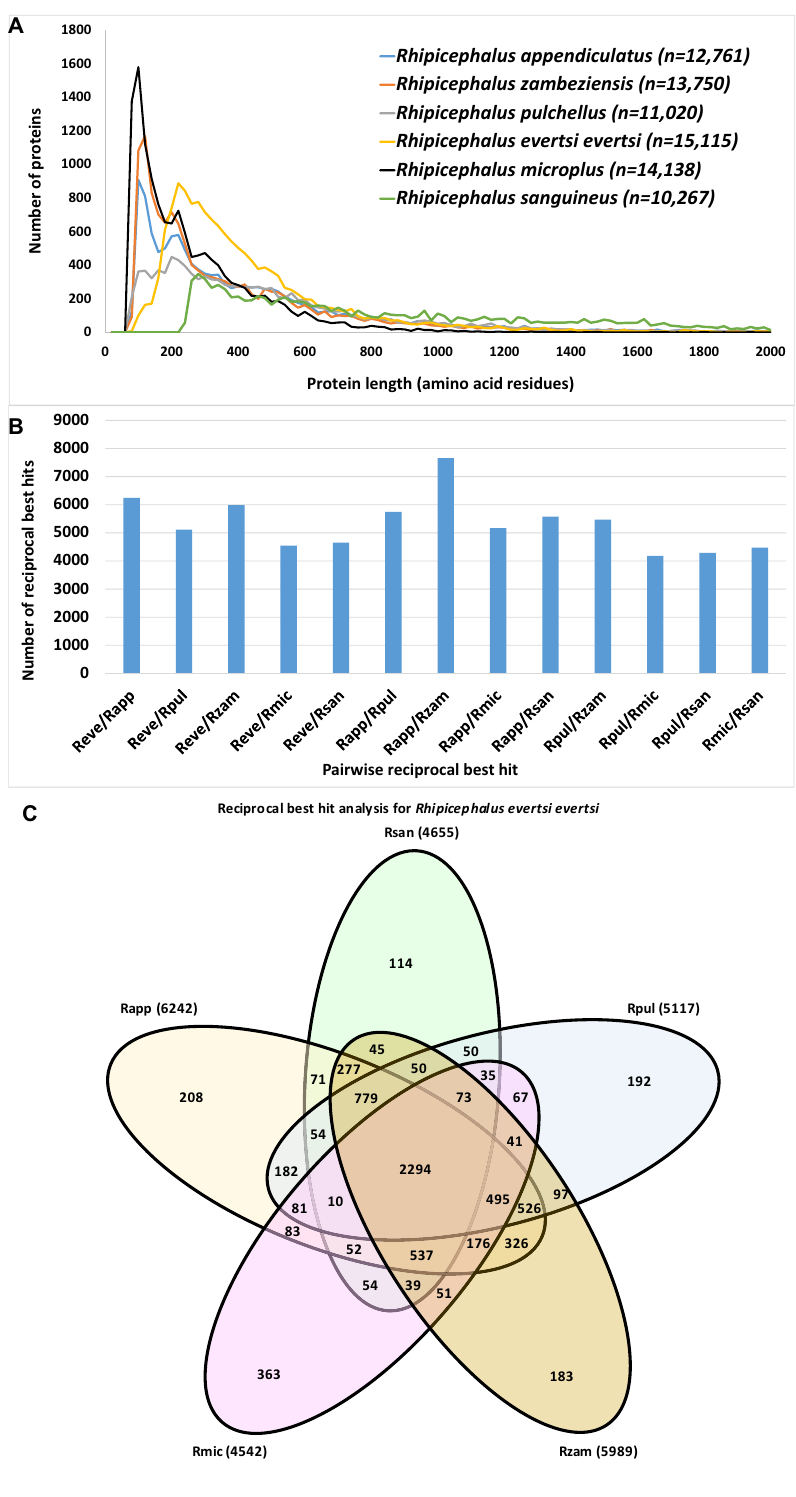
Figure 2. Comparison of the Rhipicephalus evertsi evertsi (Reve) transcriptome with other publically available Rhipicephalus transcriptomes that include Rhipicephalus appendiculatus (Rapp), Rhipicephalus microplus (Rmic), Rhipicephalus pulchellus (Rpul), Rhipicephalus sanguineus (Rsan) and Rhipicephalus zambeziensis (Rzam). ( A ) A plot of the protein length in amino acid residues presented up to 2000 residues against the number of proteins. Proteins were binned in windows of 20 based on protein length. ( B ) Pairwise reciprocal best hit analysis for the publically available Rhipicephalus transcriptomes. ( C ) Venn diagram to show the number of shared orthologs found for the Rhipicephalus evertsi evertsi transcriptome based on reciprocal best hits. Similar diagrams can be found for the other publically available Rhipicephalus transcriptomes in the supplementary material. Numbers in parenthesis indicate total number of reciprocal best hits for each transcriptome and while those shared among transcriptomes are indicated in